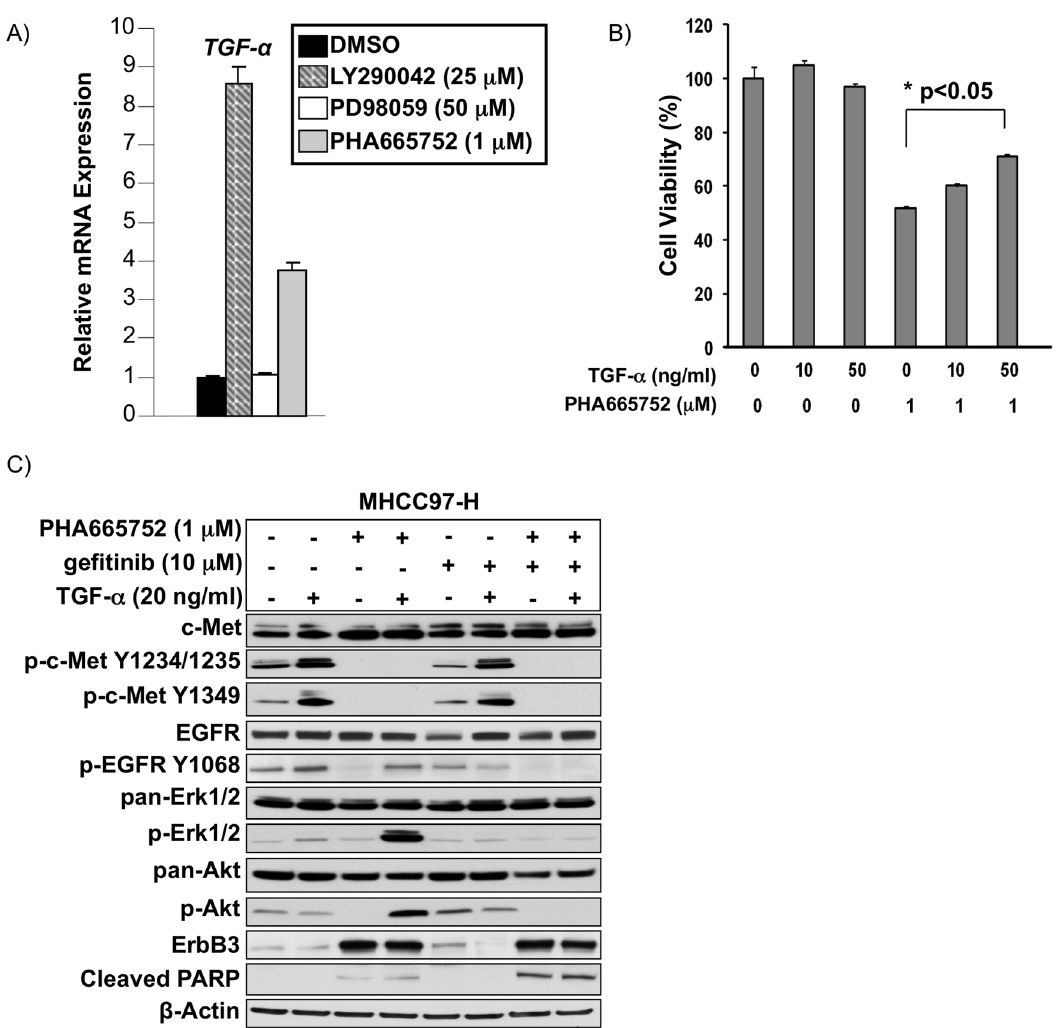
Fig 5. Transforming growth factor alpha (TGF- α ), an EGFR ligand, is regulated by PI3K/Akt signaling downstream of c-Met and can act as a compensatory survival mechanism during c-Met blockade in c-Met + HCC. A) TGF- α mRNA expression by qRT-PCR in MHCC97-H cells treated with